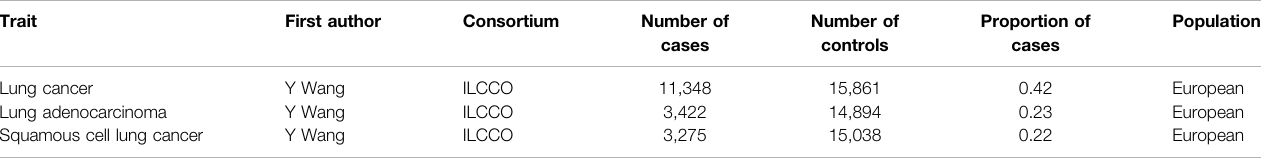
TABLE 1 | Details of epidemiological individual-level data of lung cancer from the International Lung and Cancer Consortium (ILCCO) included in Mendelian randomization